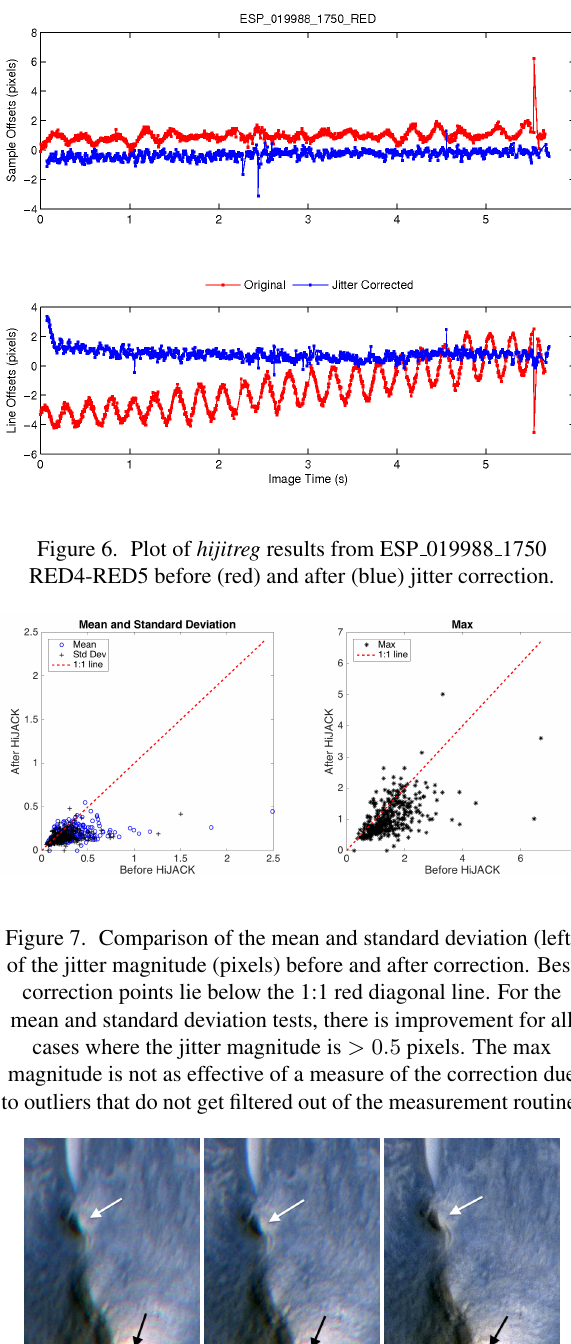
Figure 8. Color registration comparison in detail (zoom level 2:1) of ESP 012039 2010. The black and white arrows point out areas where obvious sample (white arrow) and line (black arrow) jitter cause color fringing. Left) No color correction shows obvious color fringing from misregistration due to jitter. Center) Color processed through HiJACK with no other correction shows improved, but not perfect, color registration. Right) Color processed with a relative correction to the RED band shows good color